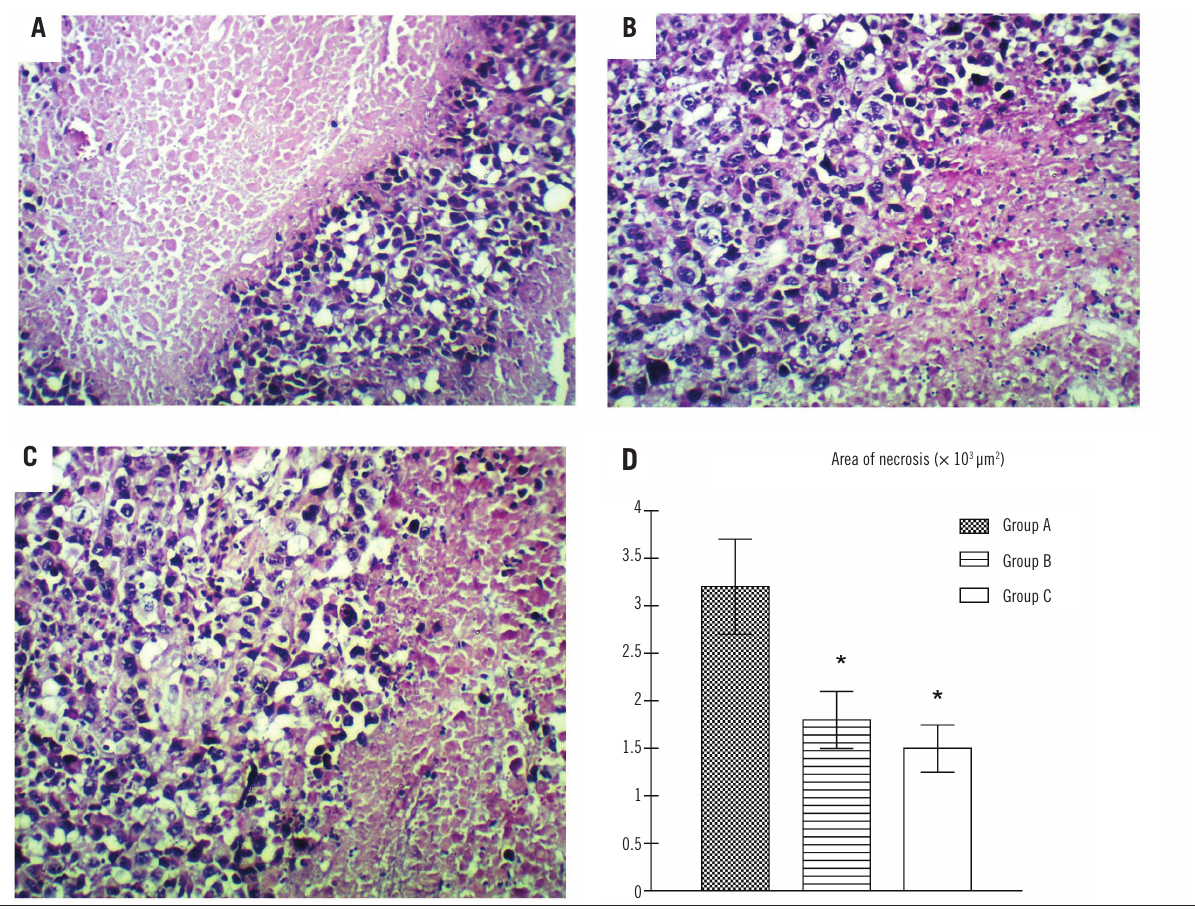
figurE 3 − Analysis of necrotic areas Histopathological analyzes of the footpads of mice inoculated with EET after 21 days, HE 100×. A) control group: presence of extensive eosinophilic area of necrosis; B) group B beginning of watercress intake prior to tumor inoculation. Presence of necrosis area to a lesser extent; C) group C: beginning of watercress intake after tumor inoculation. Presence of necrosis area to a lesser extent; D) semi quantitative analysis of the areas of necrosis. * p < 0.05 compared to the control group, results expressed as mean and standard deviation with n = 6/group. EET: experimental Ehrlich tumor; HE: hematoxylin and